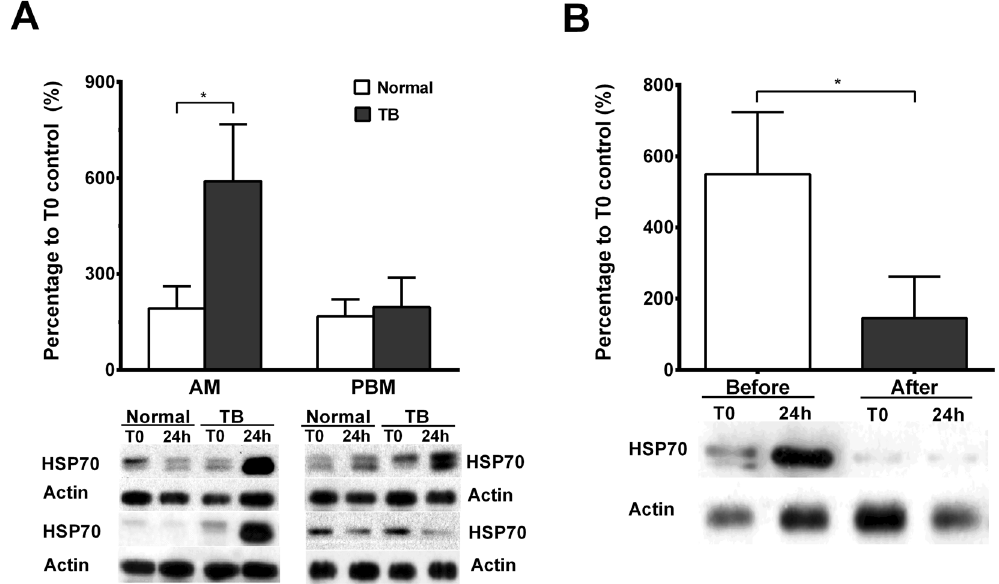
Figure 1. ( A ) Levels of HSP70 in alveolar macrophages (AM) and peripheral blood monocytes (PBM) quantified by western blot analysis in patients with active pulmonary TB (TB, n = 6) and normal subjects (Normal, n = 6). * p < 0.05 compared with normal subjects. ( B ) Levels of HSP70 in AM from TB patients (n = 5) before and after receiving anti-TB treatment for 3 M quantified by western blot. * p < 0.05 compared with before anti-TB